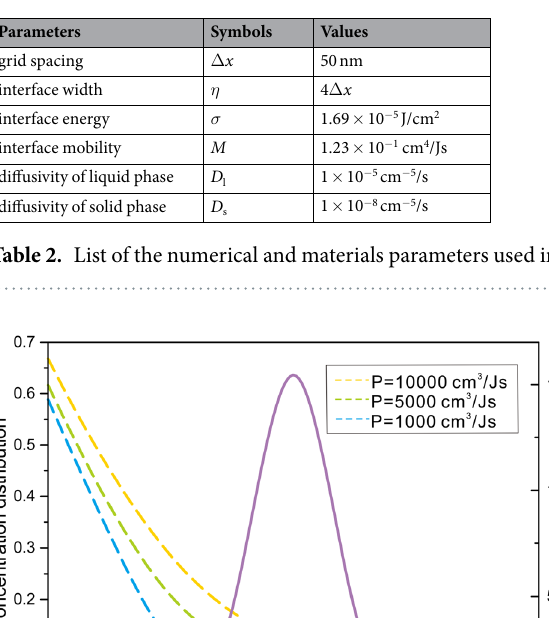
numerical parameters used in the present three-dimensional (3-D) phase-field simulation are listed in Table 2, except for the values of the interface permeability P . The interfacial energy σ was directly adopted from 14 , while the interface mobility M was calculated according to 11 for keeping in the diffusion-controlled regime. Ds and D l were simply set to be constants 15 . The simulation domain was chosen to be of 128 × 128 × 128 grid points. The boundary conditions for all the phase fields and concentrations were set to be periodic. First, the impact of permeability on the nucleation process is explored, as already explained above, and varia- tion of permeability will lead to changes in the nucleus concentration and the nucleation driving force, even if the melt concentration is the same. Furthermore, the concentration distribution in the melt is represented in Fig. 5 (Note that here it is only intended to exhibit the practicability of the model, not to provide a result with high pre- cision), and the dashed lines corresponding to different permeabilities are the calculated nucleation driving force curves. It is apparent that the nucleation driving force will be inhibited with the reduction of permeability, hence the change of permeability has noticeable impact on the nucleation events. Then, the formation of the nucleus is followed by its dendritic growth. The 3-D phase-field simulation for grain growth evolution in Al-2.89 at. % Si alloy corresponding to different permeabilities are enumerated in Fig. 6. Figure 6(a) shows the morphology evolution of microstructure while Fig. 6(b) displays the concentration evolution of the nucleus. Obviously, the permeability has a great influence on the initial concentration of nucleus whereas it is almost impervious for both the grain growth and the subsequent concentration evolution of nucleus. Later on, solidification processes with different interface permeabilities (i.e., 1000 cm 3 /Js, 5000 cm 3 /Js and 10000 cm 3 Js) in Al-2.89 at. % Si alloy were simulated by the 3-D phase-field model and are exhibited in Fig. 7. From the three evolutionary graphs it can be seen clearly that the nucleus are precipitated continuously with the liquid concentration undulating, nucleation is almost impossible to occur in Fig. 7(a) while the occurrence of nucleation is very easy in Fig. 7(c), thus it can be said without exaggeration that a high interface permeability is likely to increase the total number of nucleation events, fully affirmed our speculation. Next, the nucleation rate curves corresponding to different permeabilities are fitted by a recently modified function similar to the LSW size distribution 16 :